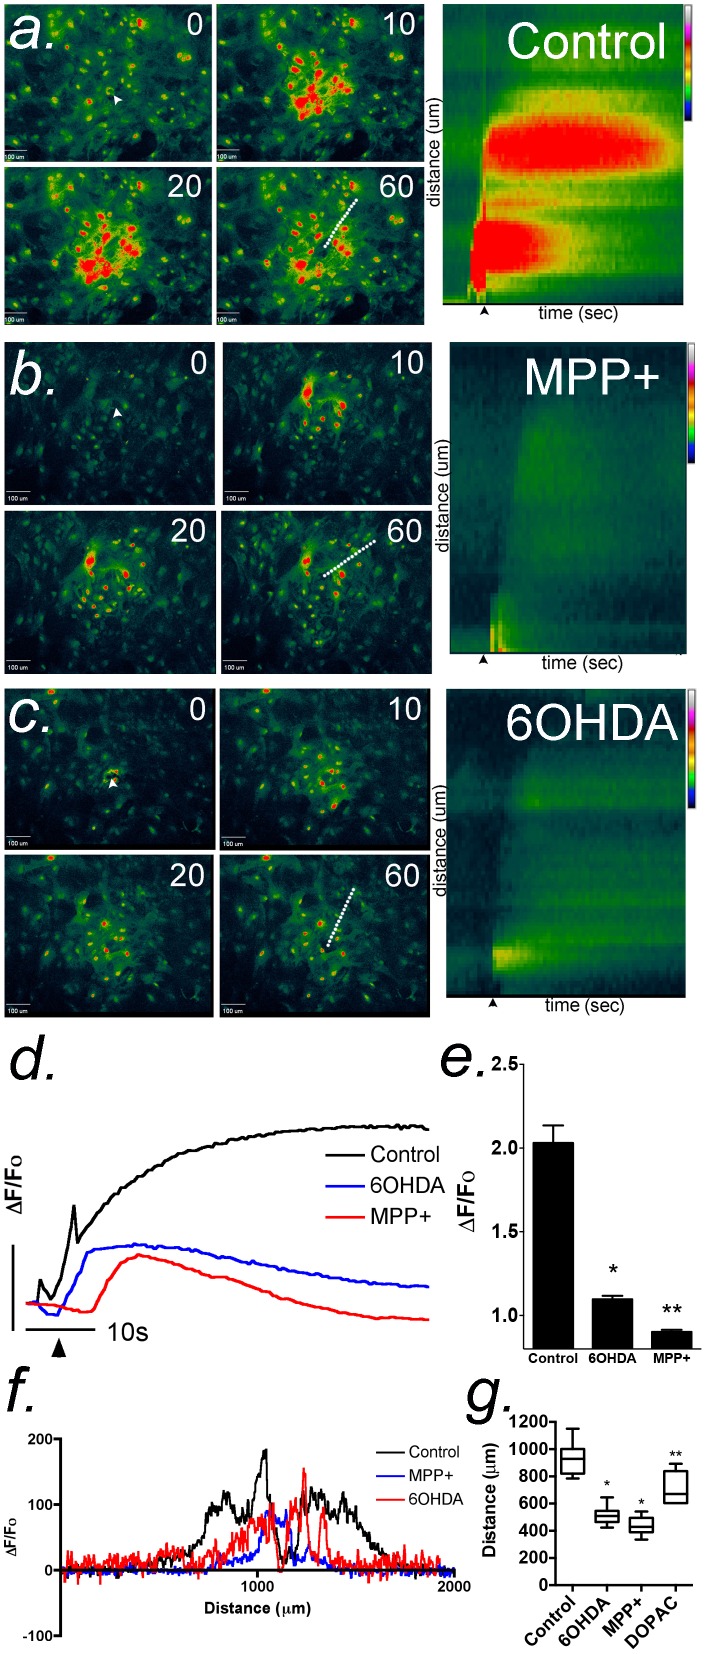
Acute exposure to dopaminergic neurotoxicants attenuates the propagation of intercellular Ca2+ waves in primary astrocytes.Calcium waves were initiated in confluent cultures of striatal astrocytes loaded with Fluo-4 AM (2 µM) using a glass micropipette to stimulate a single astrocyte in the center of the field (white arrow). Images were collected every 500 msec for 60 sec. (a) Control wave and kymograph images were generated from the fluorescence intensity of Fluo-4 along a representative line drawn from the point of stimulation to the terminus of the Ca2+ wave across across the field of astrocytes (a, dotted line). Black arrows denote the point of stimulation. (b) The extent and intensity of Ca2+ waves is sharply diminished by acute application of 100 µM MPP+. (c) Similarly to MPP+, 100 µM 6-OHDA diminished the extent and intensity of Ca2+ waves with acute application. (d,e) The mean intensity of intracellular Ca2+ responses in the cells acutely exposed to 100 µM MPP+ and 6-OHDA are significantly decreased compared to control. The vertical bar in (d) denotes 1 relative fluorescent unit; the horizontal bar denotes 10 sec. (f,g) Representative traces of the total distance of the wave front in control and acutely-treated cells. Quantitative analysis of Ca2+ wave propagation indicates that 100 µM MPP+ and 6-OHDA decreases the distance traveled in striatal astrocytes by>50% relative to control, whereas 100 µM DOPAC does not abolish wave distance like MPP+ and 6-OHDA although significantly decreased from control. n = 3 waves analyzed per group for each experiment over 3–4 independent experiments in separate cultures of striatal astrocytes; *p<0.05 relative to control, ** p<0.01 relative to control and treated groups.